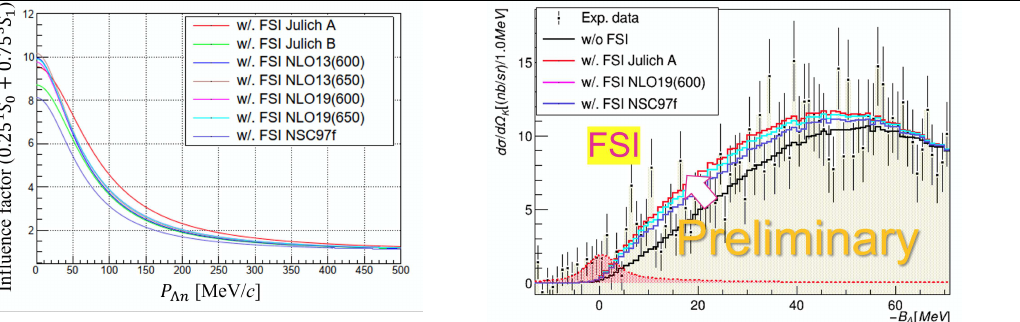
Figure 3. The missing mass spectra with Λ n FSI. The black and colored solid lines show the SIMC spectrum without the Λ n FSI and with the Λ n FSI in each potential